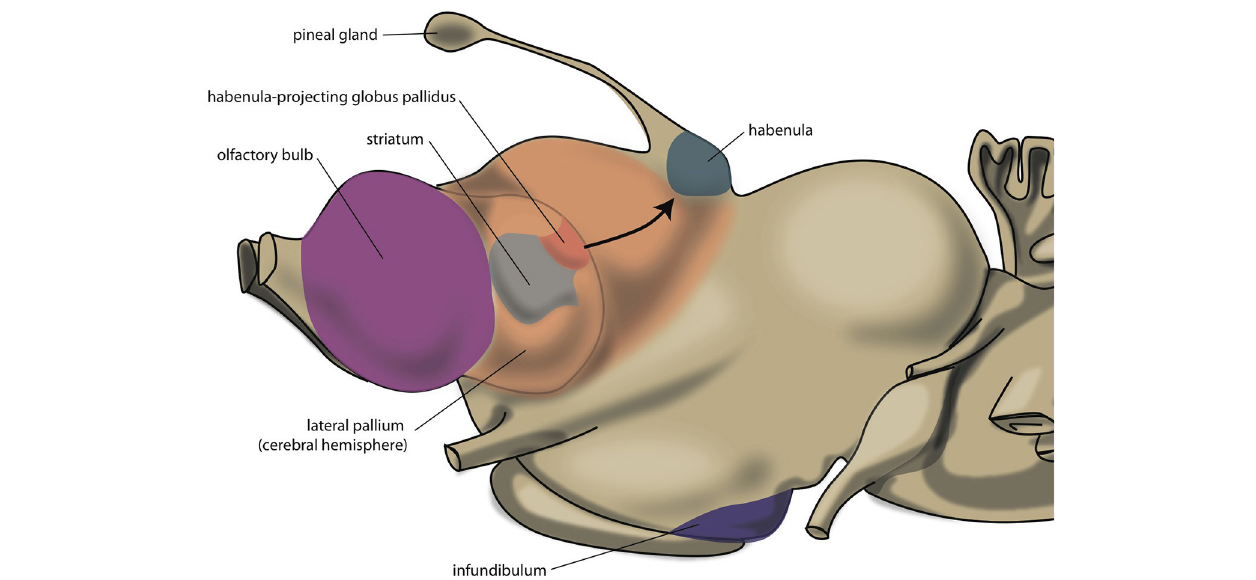
FIGURE 3 | Position of striatum and habenula-projecting globus pallidus of lamprey.